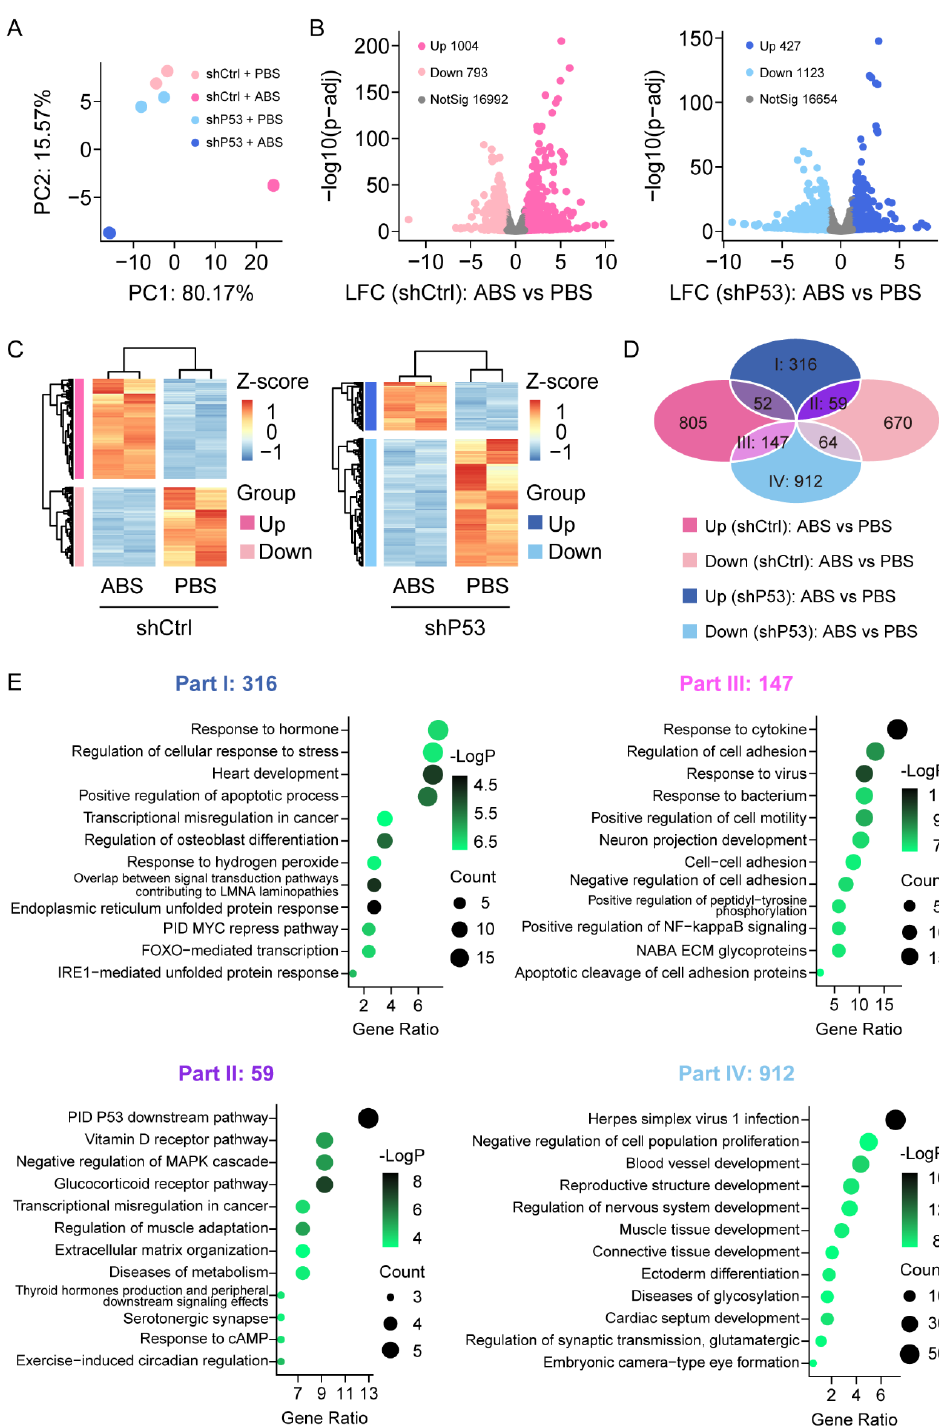
Figure 3. Transcriptome of the esophageal epithelium cells with or without P53 knockdown after ABS treatment. ( A ) PCA of transcriptome data for HET1A with or without P53 knockdown after 30 days of exposure to ABS. ( B ) Volcanic graph analysis of gene expression of the control group (left) and P53 knockdown HET1A cells (right). ( C ) Heatmap of genes expression of the control group (left) and P53 knockdown group (right) before and after exposure to ABS. ( D ) Venn diagram analysis of gene expression various in P53 silenced HET1A cells and control group with or without ABS treatment. ( E ) GO enrichment analysis of differentially expressed genes in Parts I – IV denoted parts in ( D ).